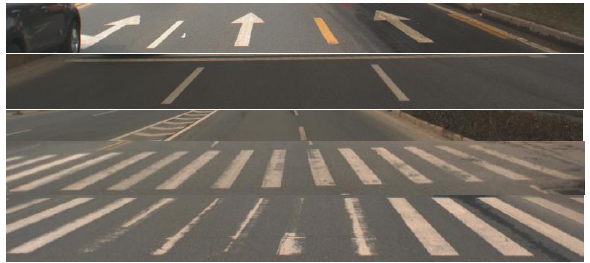
Figure 5. Common AOIs obtained after high-pass